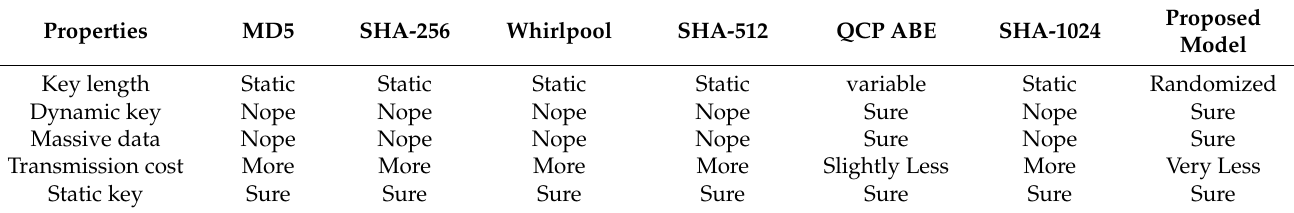
Table 2. Summary of comparisons of state-of-the-art literature with proposed